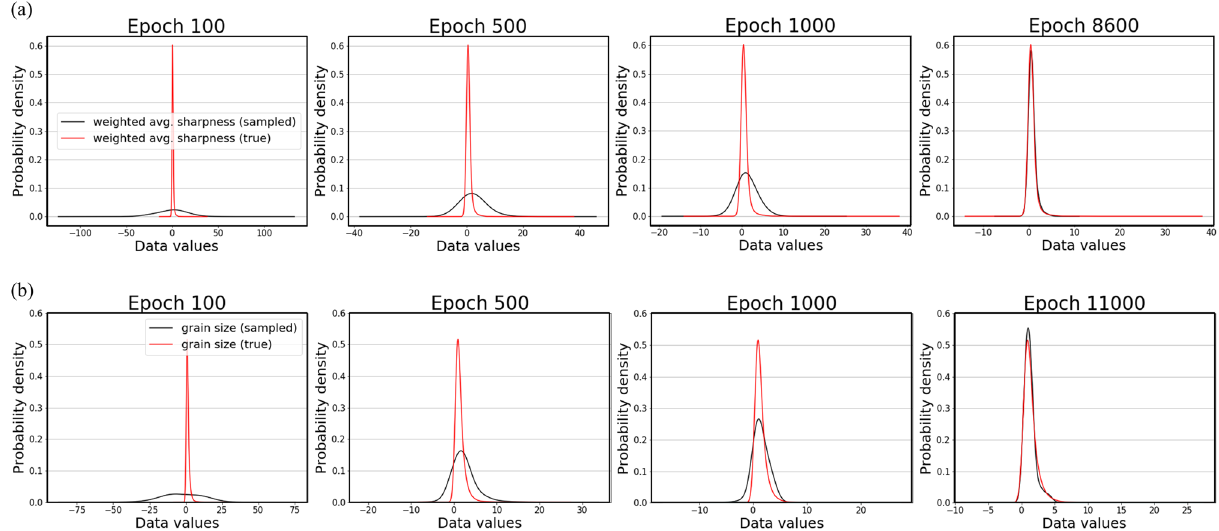
Figure 7. ( a ) PDFs for Steel E. ( b ) PDFs for Steel F. The ground truth is shown in a red curve while the estimated PDF is in a black